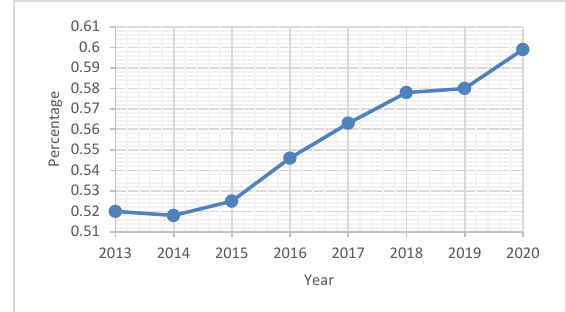
Fig. 3. Divorce digital certificates evolution 2013- Fig. 4. Users´ satisfaction with RENIEC